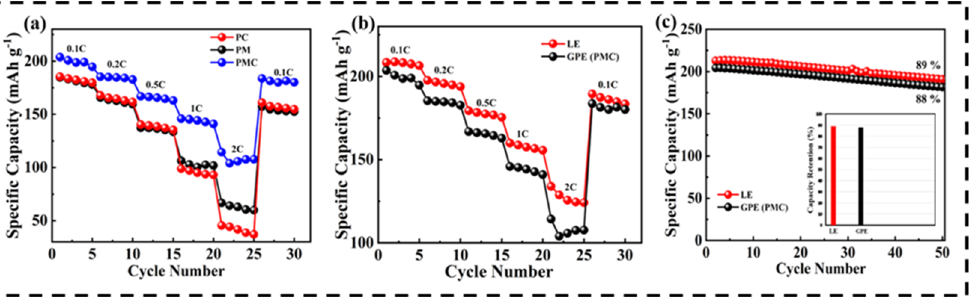
Figure 8. ( a ) Rate capability studies of NCM811/Li half-cell using PM-, PC-, and PMC-based GPEs; ( b ) Comparative rate capability studies for LE and GPE (PMC); ( c ) cyclic stability and capacity retention for LE and GPE (PMC).